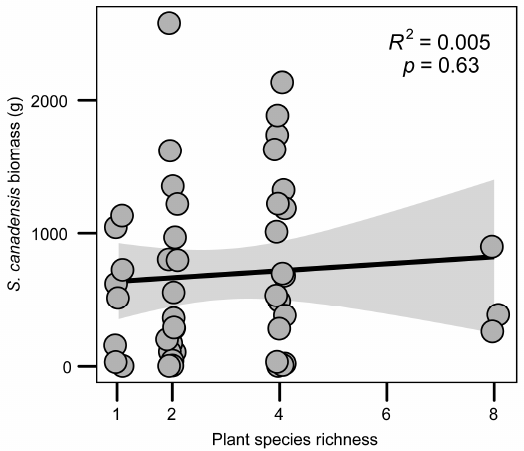
Figure 1. The relationship between invader biomass and native plant species richness.